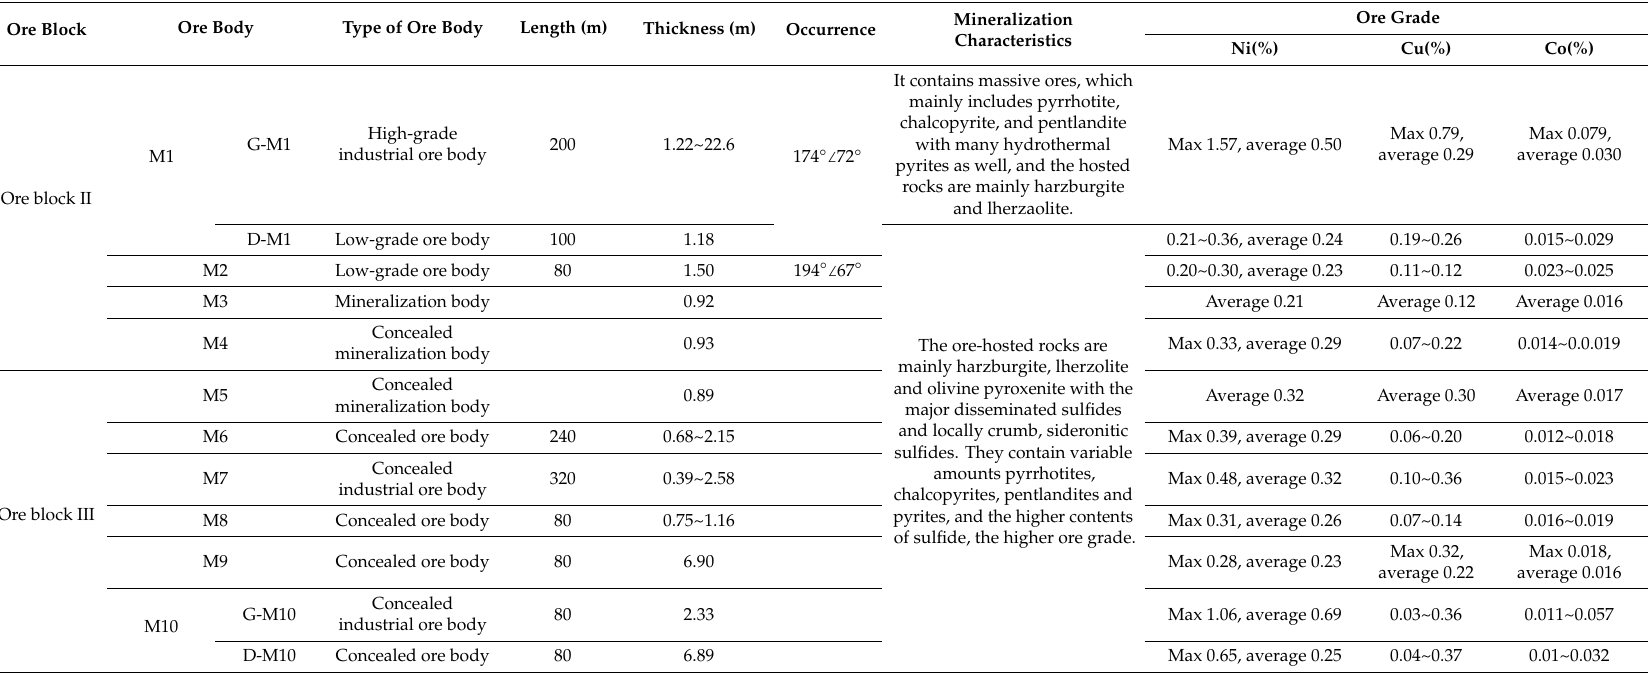
Table 1. Characteristics of the Ni-(Cu) ore / mineralization body in the Niubiziliang Ni-(Cu)